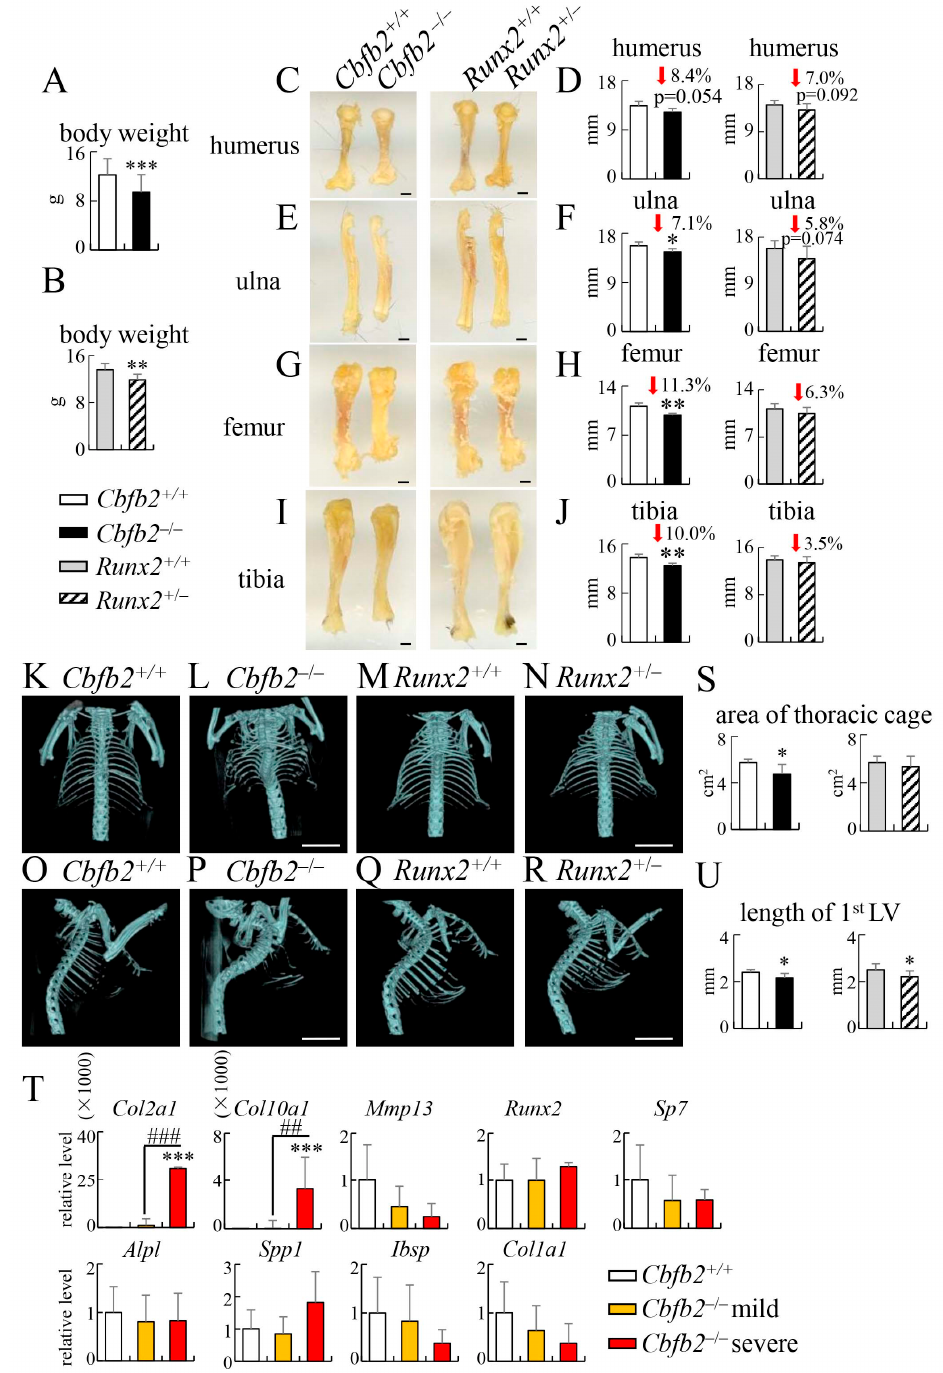
Figure 8. The development of limb bones, ribs and vertebrae in Cbfb2 –/– and Runx2 +/– mice at 4 weeks of age. ( A , B ) Body weights of male mice. n = 21–29. ( C – J ) The lengths of the humerus ( C , D ), ulna ( E , F ), femur ( G , H ) and tibia ( I , J ) in female mice. The number of mice analyzed: Cbfb2 +/+ , n = 6; Cbfb2 –/– , n = 4; Runx2 +/+ , n = 8; Runx2 +/– , n = 7. ( K – U ) Three ‐ dimensional images of frontal ( K – N ) and lateral views ( O – R ) of thoracic cage and vertebrae in micro ‐ CT, the area of thoracic cage ( S ), real ‐ time RT ‐ PCR analysis using bony segments of rib RNA ( T ) and the length of the 1st vertebrae ( U ) in male mice. Cbfb2 –/– mice with mild or severe rib deformity were analyzed separately in ( T ). Scale bars: 1 mm ( C , E , G , I ) and 1 cm ( K – R ). Data are shown as the mean ± SD. * p < 0.05, **, ## p < 0.01 and ***, ### p < 0.001. The number of mice analyzed: Cbfb2 +/+ , n = 4; Cbfb2 –/– , n = 8 (4 mild and 4 severe); Runx2 +/+ , n = 8; Runx2 +/– , n = 7.